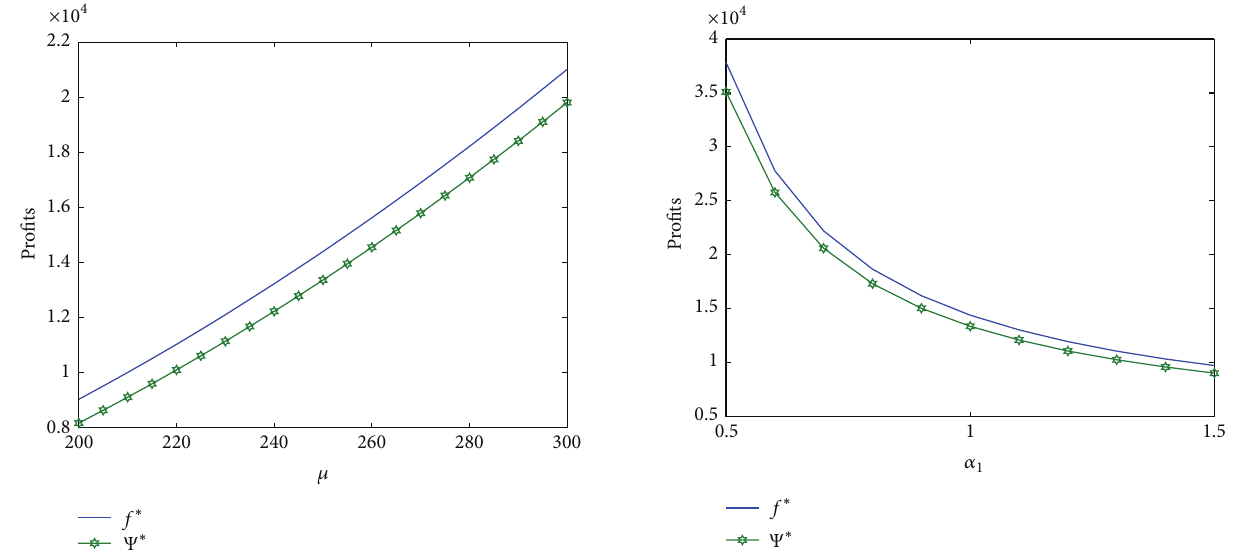
Figure 15: Impact of 𝛼 1 on the profits under demand certainty and uncertainty.